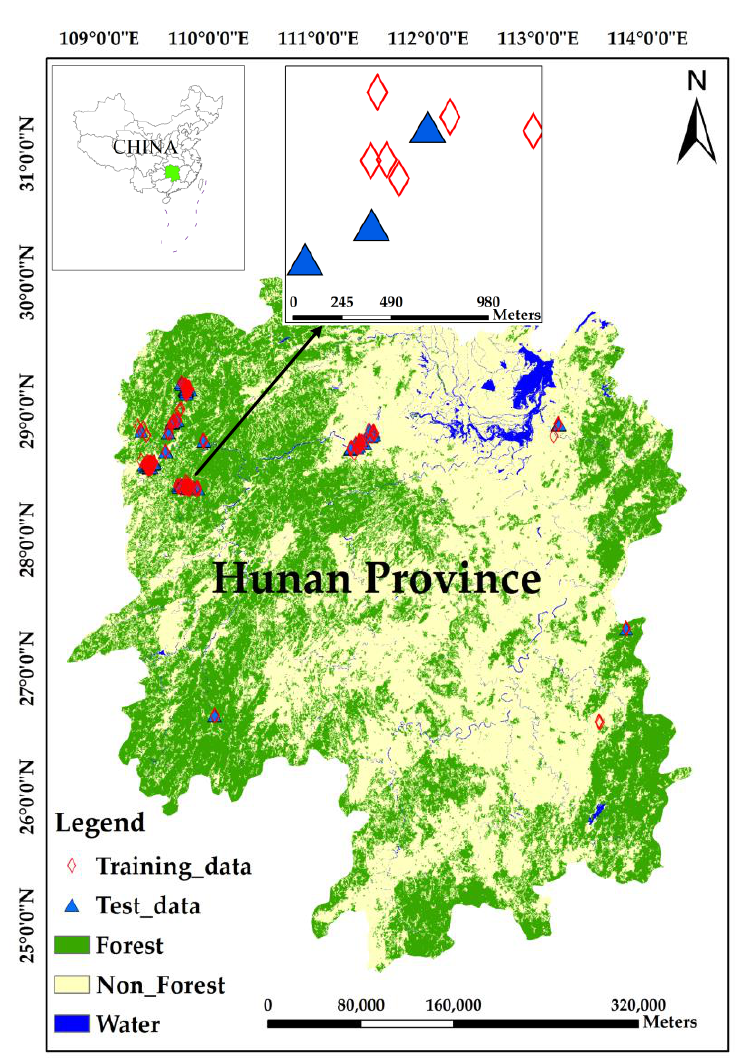
Figure 1. The study area, Hunan Province, and the distribution of the sampling plots (training data and test data). Note: “Forest” is defined as a natural forest with an area larger than 0.5 ha and forest cover over 10%.